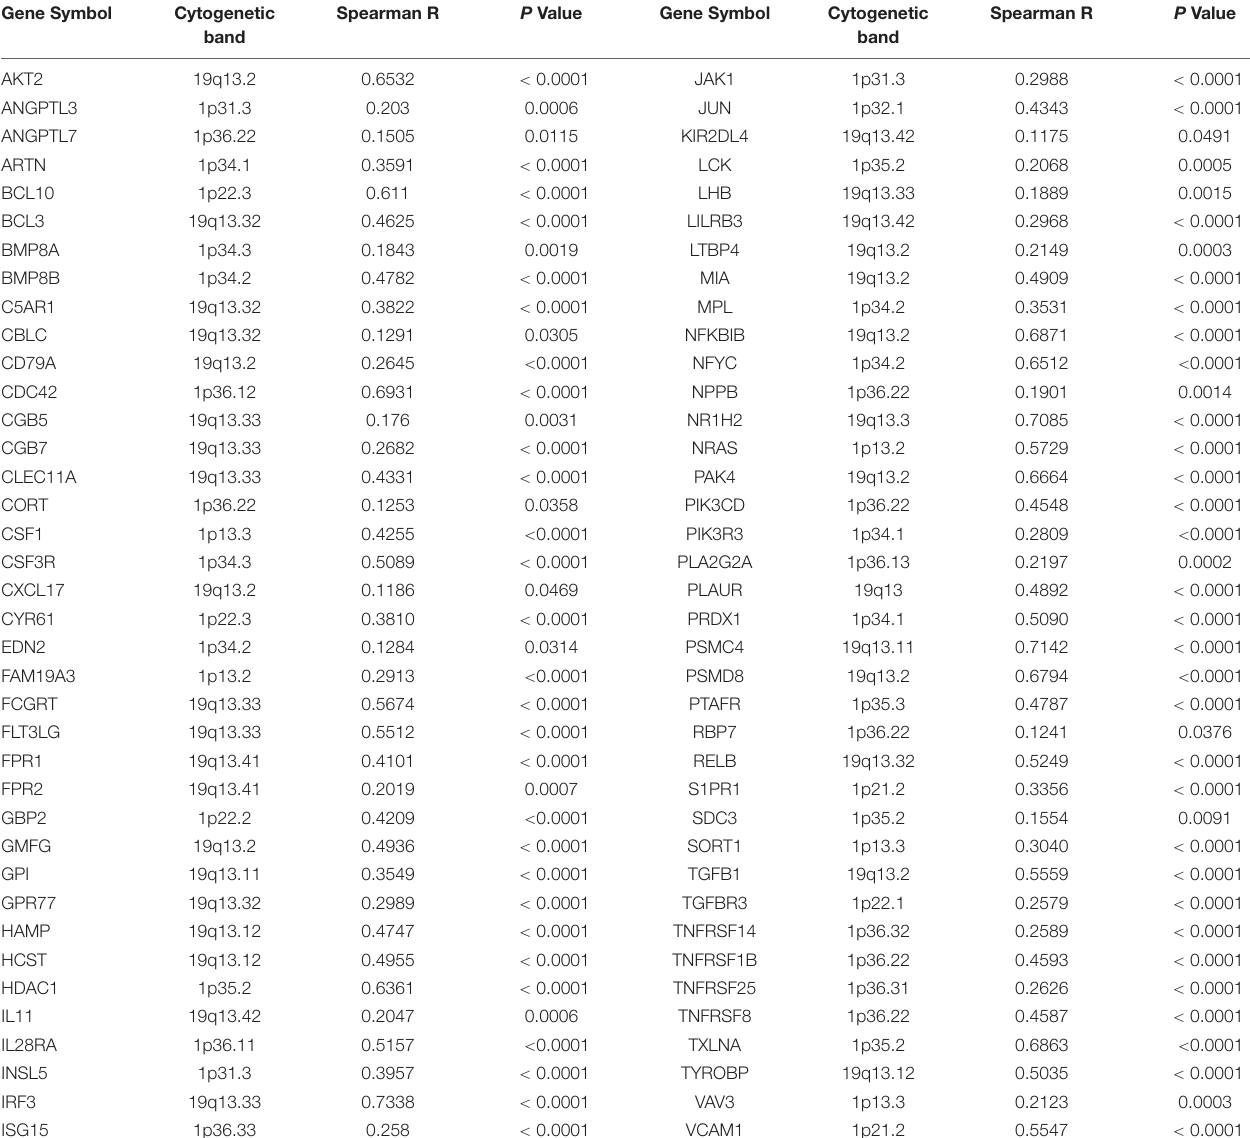
TABLE 1 | Positive correlation between copy number and mRNA expression of immune-related genes mapped on chromosome 1p and 19q. Gene Symbol Cytogenetic